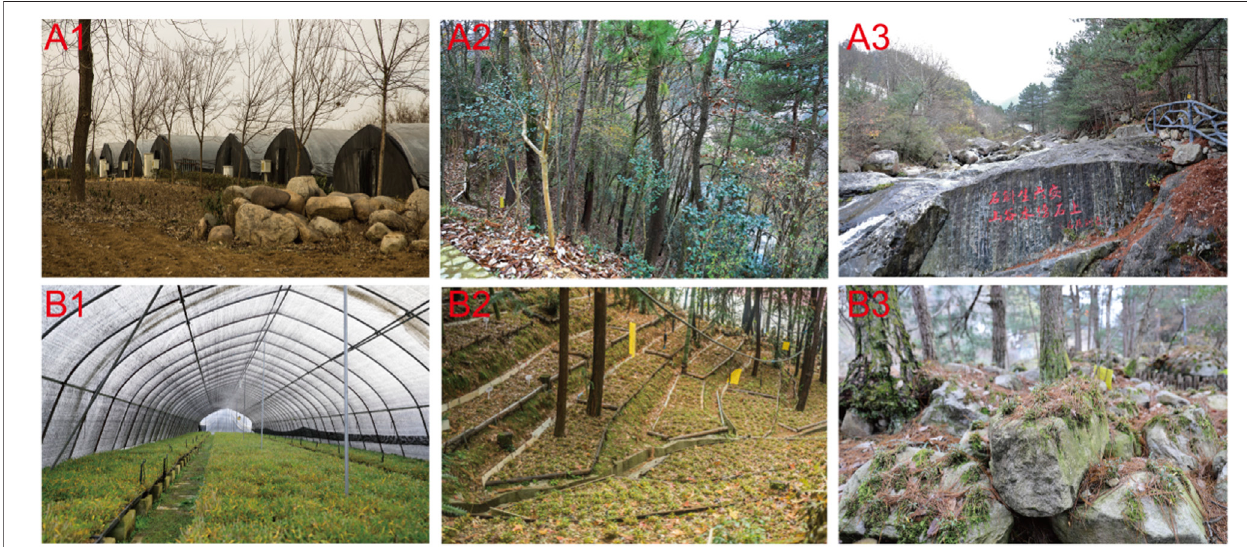
FIGURE2 | External (A1 – A3) and internal (B1 – B3) growth environments of D. huoshanense under the facility cultivation mode, under-forest cultivation mode, and simulative habitat cultivation mode, respectively.